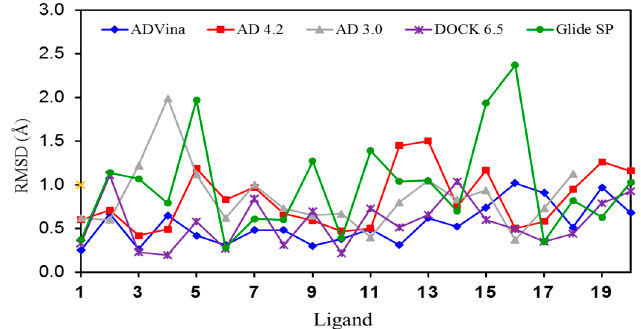
Figure 2. Graphic representation of the RMSD values for the self-docking of ligands 1 – 20 into their corresponding binding sites (crystal structures). Table 1. RMSD values (in Å) and scoring energies a for the self-docking of each ligand in its binding site.